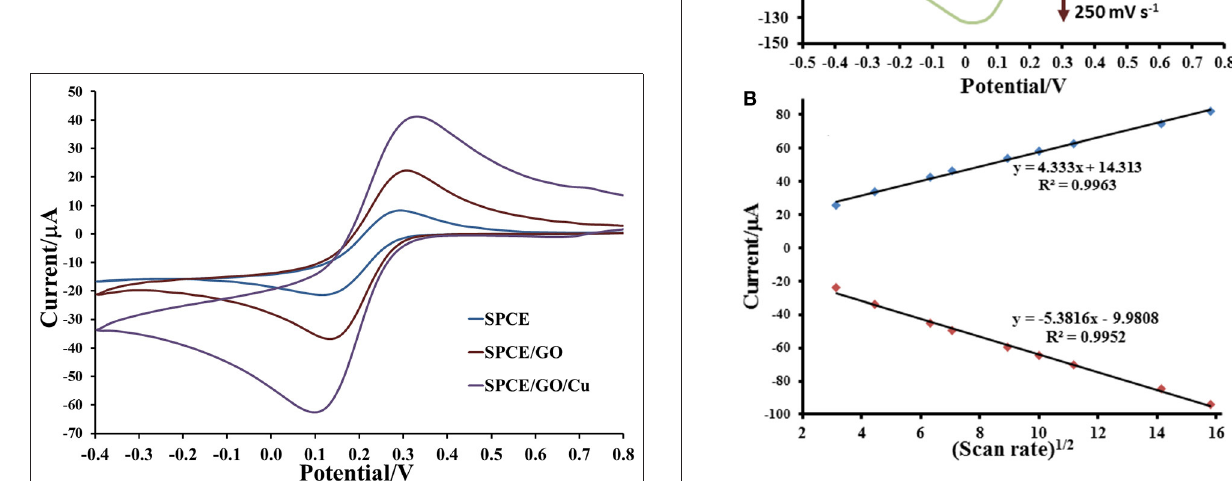
FIGURE 4 | Electrochemical properties of bare SPCE and GO- and Cu(II)/GO-SPCEs in contact with 0.010M PBS containing 5mM [Fe(CN) 6 ] 3 − .